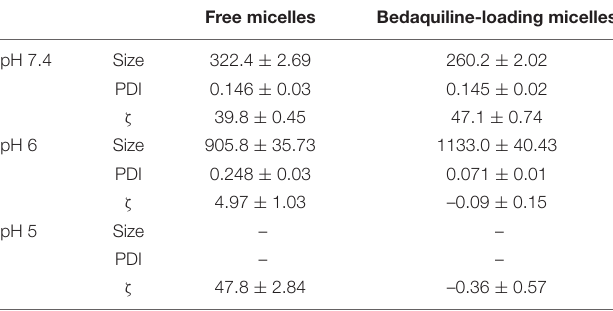
TABLE 2 | Particle size and zeta potential of free micelles and bedaquiline-loading micelles based on DLS. Free micelles Bedaquiline-loading